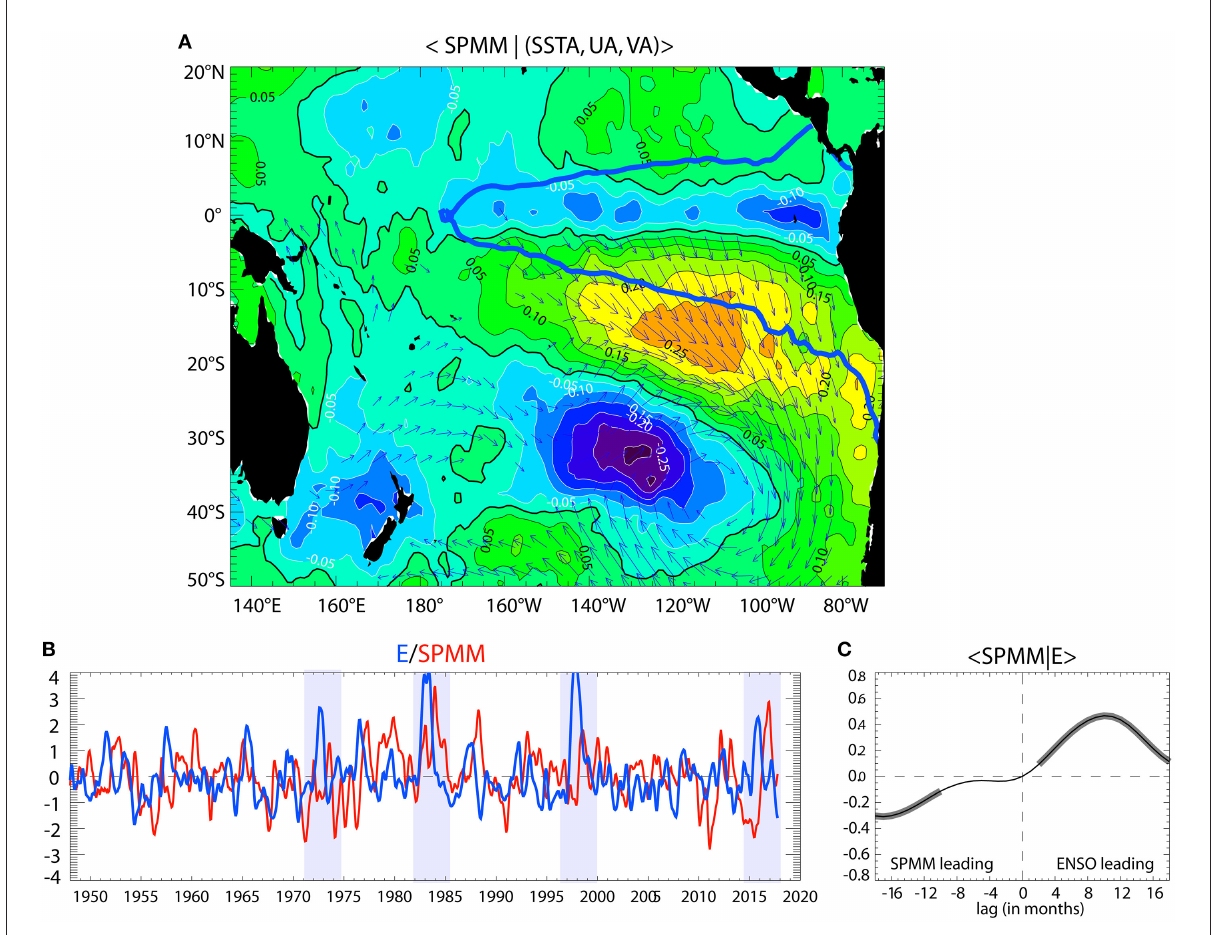
FIGURE1 (A) Regression map of the SVD leading mode SST/Wind expansion coefficients for the SST and 10-m wind vectors. The expansion coefficients have been normalized so that units are ◦ C and m/s for SST and wind respectively. The longest arrow on the maps corresponds to a wind amplitude of 0.66 m/s. The mode explains 70% of the covariance between the variables. The contour in thick blue line corresponds to the iso-contour 0.25 ◦ C of the E mode pattern. (B) Time series of the SPMM index (i.e., expansion coefficient of the first SVD mode for SST) and the E index. The shading indicates periods of strong EP El Niño events (1972/73, 1982/83, 1997/98 and 2015/16). (C) Lagged correlation analysis between the SPMM and E indices. The segments in thick line indicate when the correlation is statistically significant at the 99% level based on a Student’s t- test. Negative lags mean that the SPMM index is ahead the E